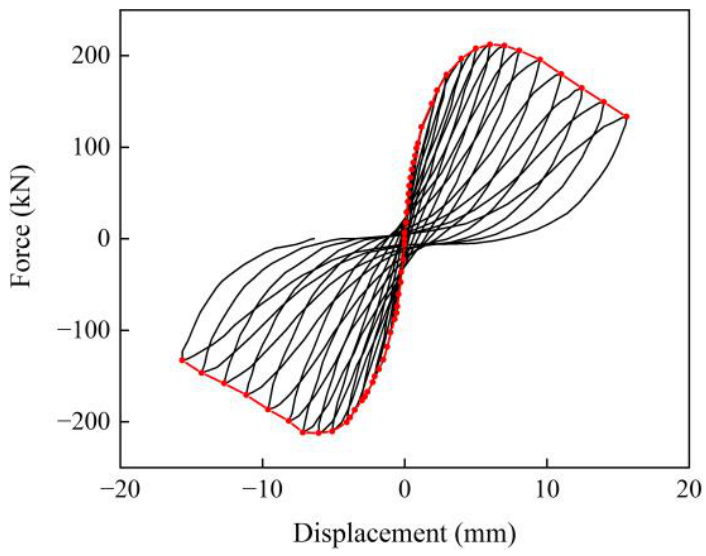
Figure 1. The hysteretic curve and skeleton curve.